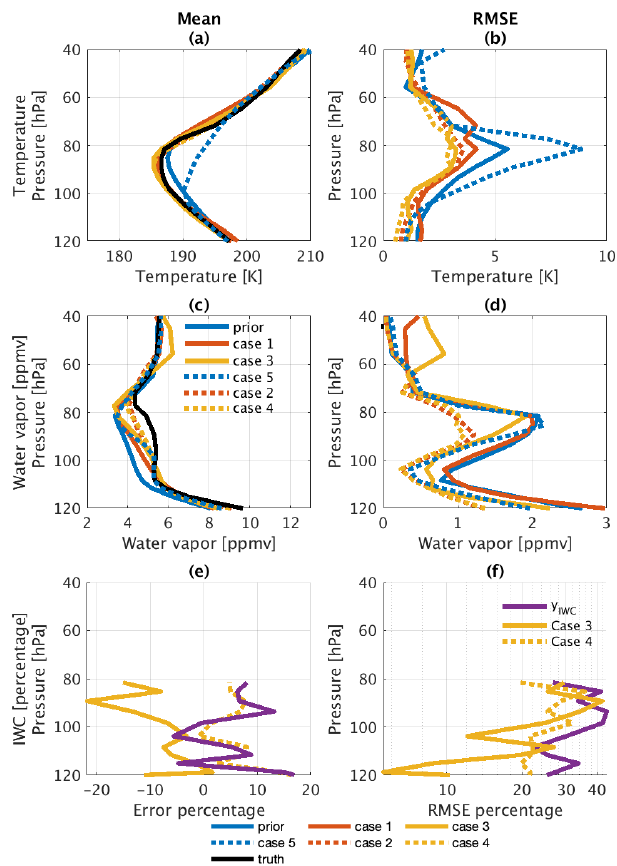
Figure 5. Profiles of the mean and RMSE of the temperature (a, b) and water vapor (c, d) for the four retrieval strategy cases. Profiles of the percent mean bias (e) and RMSE (f) of the IWC are also shown. Blue curves show the bias and RMSE in the prior. Red curves re- fer to cases where the retrieval strategy uses the slab-cloud method (solid lines for Case 1 and dotted lines for Case 2), while yellow curves refer to cases where the retrieval strategy uses the synergis- tic method (solid lines for Case 3 and dotted lines for Case